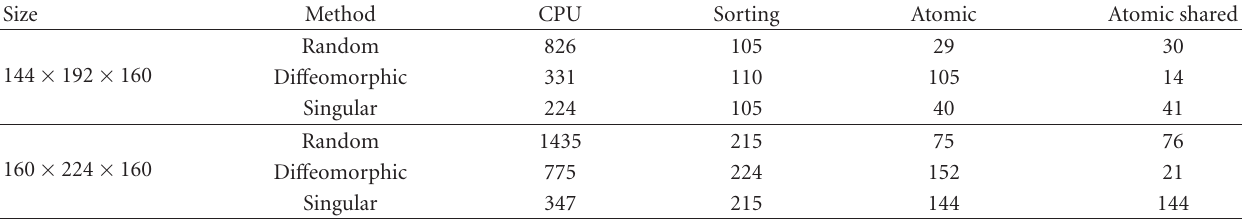
Table 2: Runtime comparison, in milliseconds, of di ff erent splatting implementations on volume sized 144 × 192 × 160 and 160 × 224 × 160 using collision-free sorting approach, atomic operation with fixed point presentation, atomic operation on the shared memory and CPU reference.